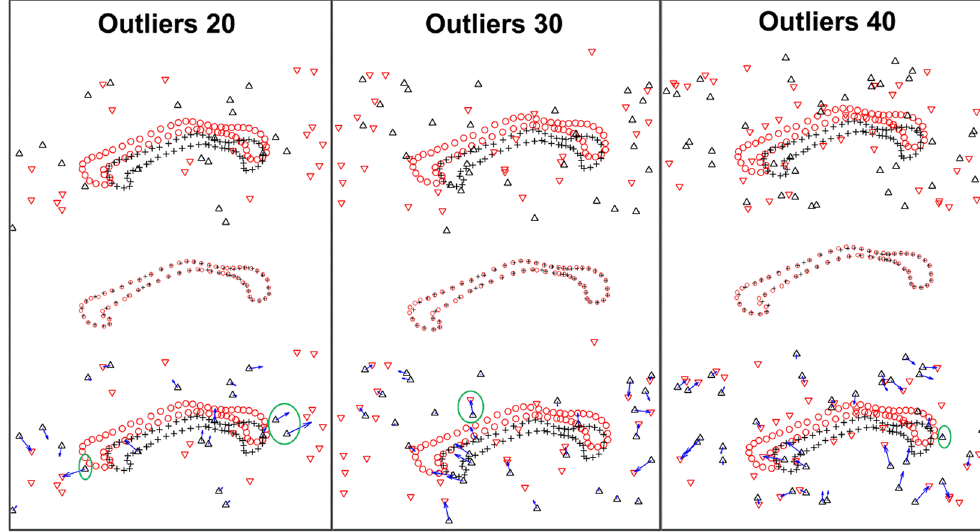
Figure 3. Performance of DSMM on 2D Corpus Callosum data with outliers. The data has been break up one-to-one correspondence by adding different number of additional uniform distribution outliers both in the template set and the target set. In the top row, the red “o” represents the data points in the target set, and the black “ + ” represents the correspondence in the template sets. For clarity, we denote outliers in the target set with red “ ∇ ”, and the outliers in the template set with black “ ∆ ”. The figures of middle row show the transformations that map all data points in the template set to their correspondences, resisting the influence of the outliers in the target set. In the bottom row, we overlap the transformations of outliers on the template set on the degenerated points before alignment, demonstrating that our method has an ability to handle most outlier, except few points very closed to the black “ + ”. The results intuitively show that DSMM is accurate and robust against significant number of outliers.